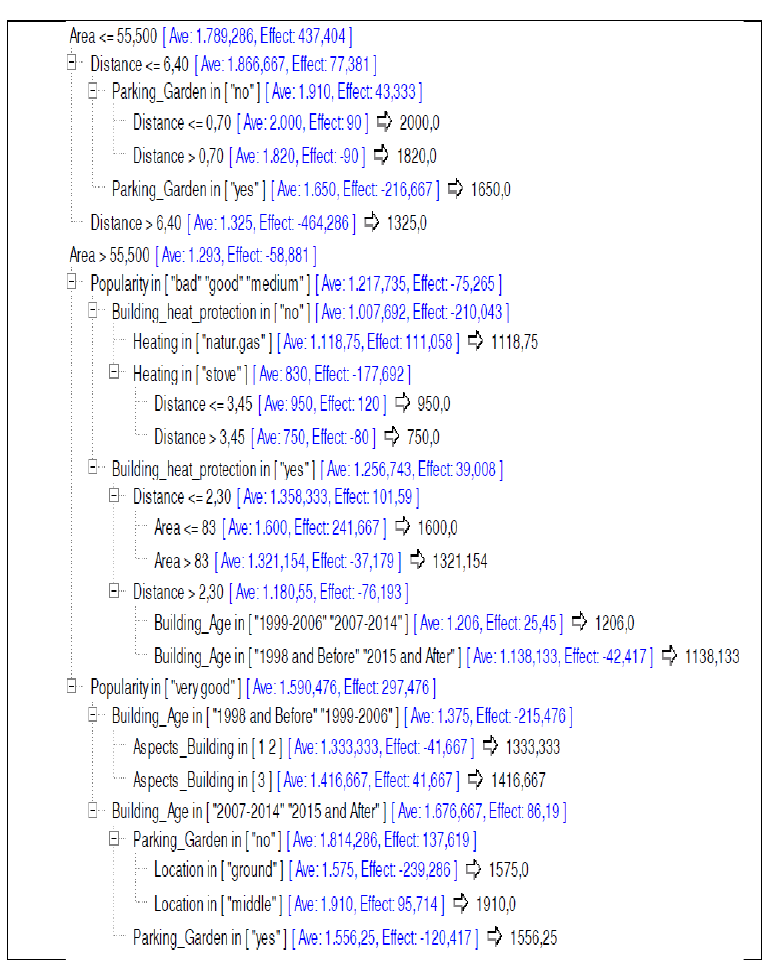
Fig. 6. C&RT model results for a real estate value (developed by the authors).